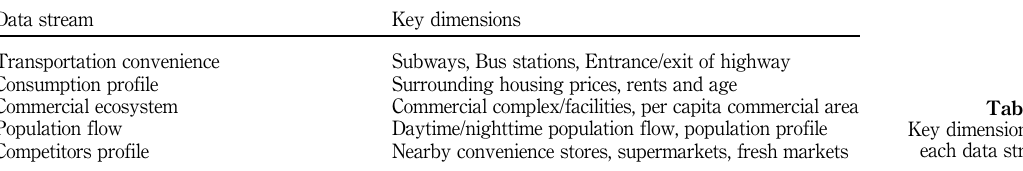
Table I. Key dimensions of each data